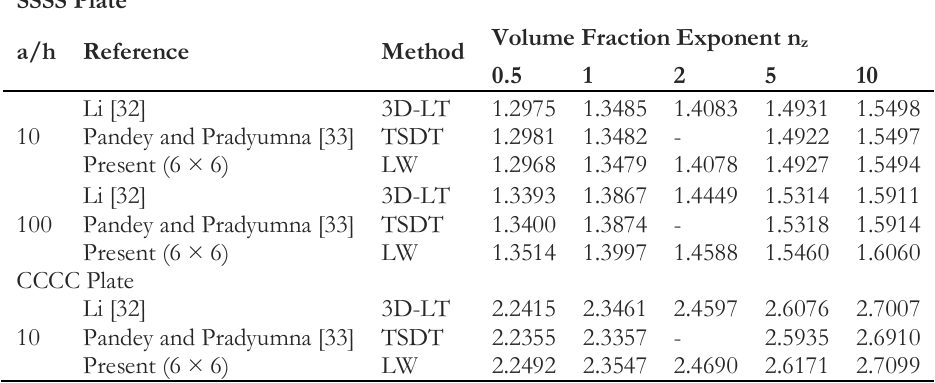
Table 5. Dimensionless fundamental frequency 𝝎̅ of (SSSS) and (CCCC) (1-8-1) Al/Al 2 O 3 Square plate embedded between ceramic and metal